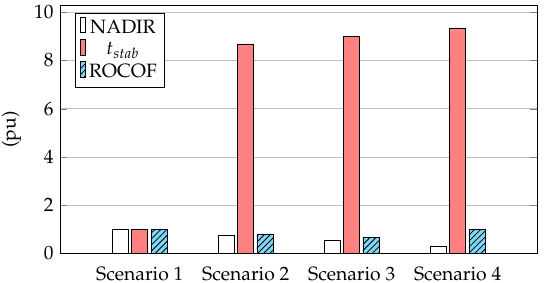
Figure 18. Comparisons between ∆ f 1 and ∆ f 2 for the different scenarios depending on the wind power plant control and considering ∆ P L = 0.050